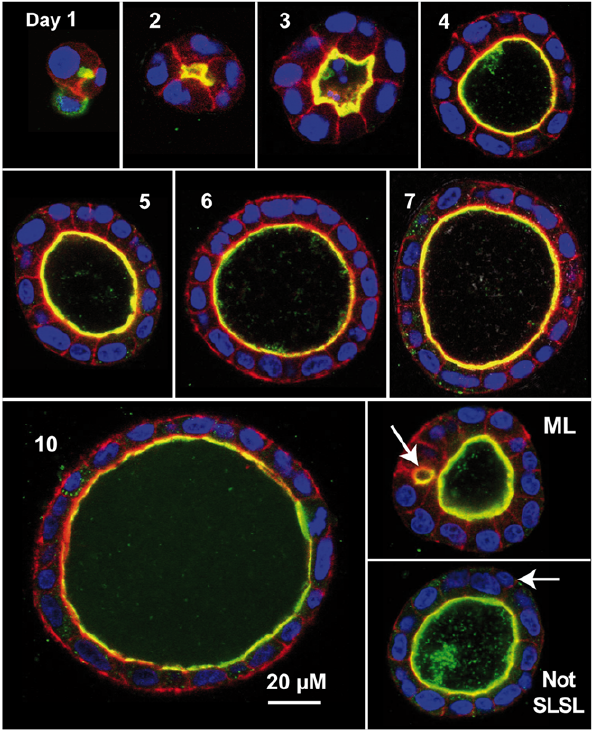
Figure 1. In vitro MDCK cyst cross-sections. Culture conditions were as described in the text. Confocal images were recorded on the indicated day during cystogenesis. Colors reflect component staining as follows: red: actin; green: gp135/podocalyxn; yellow: red and green colocated; blue: nuclein; black: Matrigel. ML: a multi-lumen cyst. The arrow indicates a second, small lumen. Not SLSL: this single lumen cyst does not have a single layer of cells. The arrow indicates a cell not in contact with